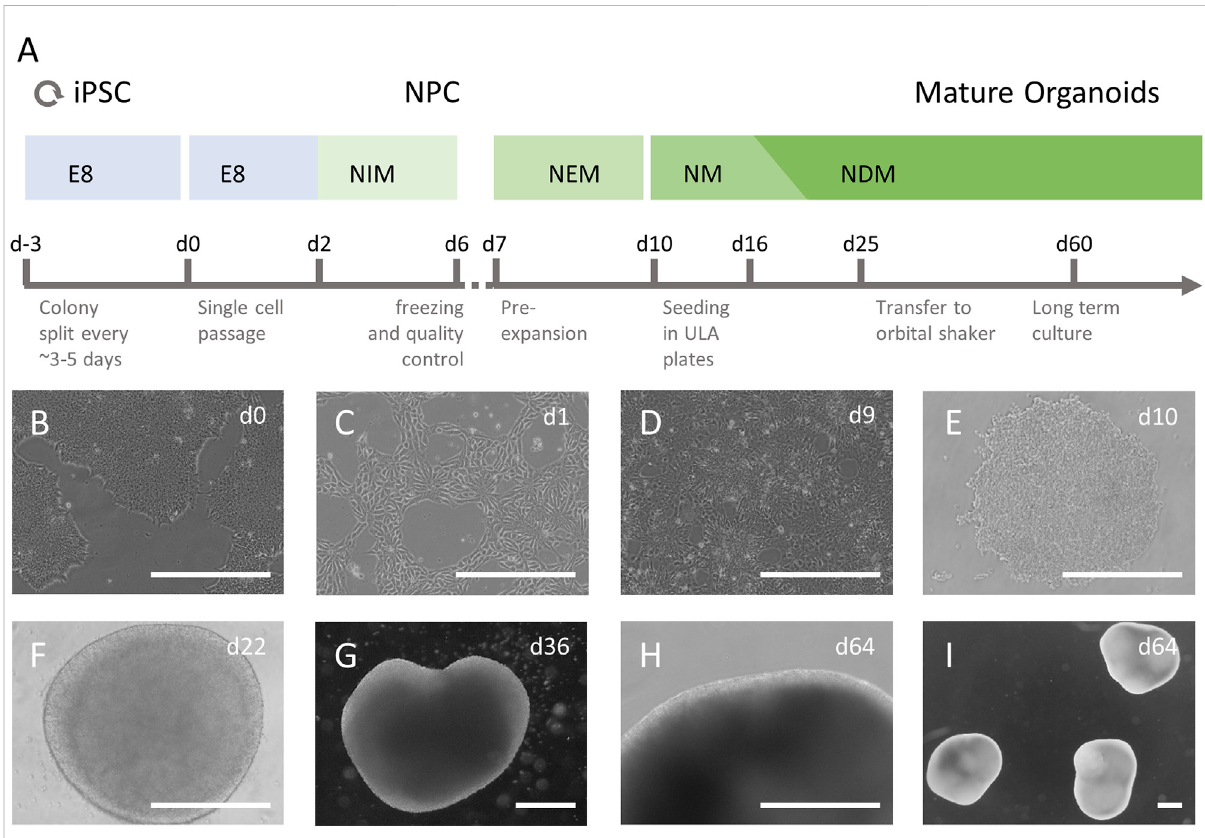
FIGURE 1 CultureofiPSCderivedhumanbrainorganoids. (A) iPSCswereculturedinessentialE8media(E8)andafterasinglecellpassagedifferentiatedto neuronal progenitor cells (NPCs) in neural induction media (NIM), containing SB431542 and Dorsomorphin. Successful differentiation was assessed, and cells were frozen. Thawed NPCs were cultured and allowed to reach near con fl uency in neural expansion media (NEM) before being seeded in 96-well ultra-low attachment (ULA) plates. The cells were grown in neural medium (NM), containing hEGF and FGF basic from d10-d15, followed by neural differentiation medium (NDM), containing BDNF and NT3 until the end of culture. On day 25, immature organoids were transferred to 10 cm 2 Petri dishes and kept on an orbital shaker at 65 rpm (B – I) Undifferentiated iPSC colonies (B) were single seeded (C) and differentiatedto NPCs (D) .The NPCs wereseededinULAplatesas single cells (E) andafter theyformedadense 3Daggregate withasmooth surface and grew in diameter (F) they were transferred to a dynamic culture system and allowed to mature (G – I) . Scale bars represent 500